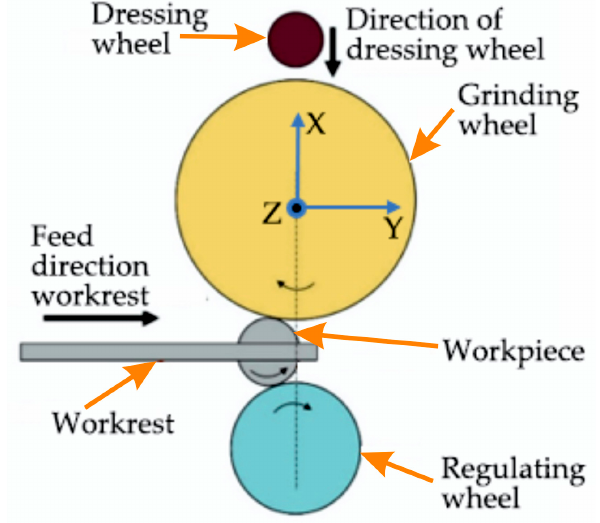
Figure 3. Technological diagram of the Nomoco VSR ‐ 5 ‐ 280.